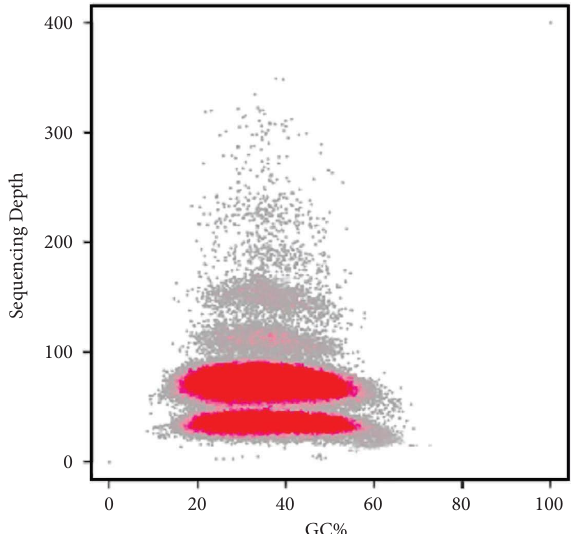
Figure 3: GC content and depth correlation graph of the CNC genome. Te red part represents the dense part of the points in the scatter